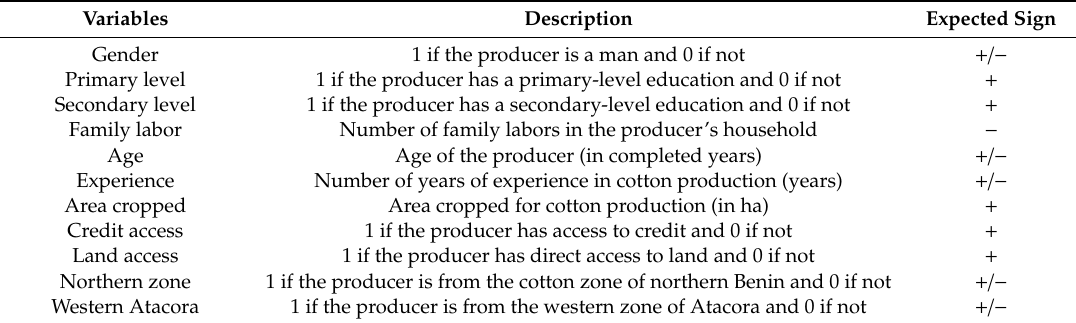
Table 1. Definition of multinomial Logit model variables and expected